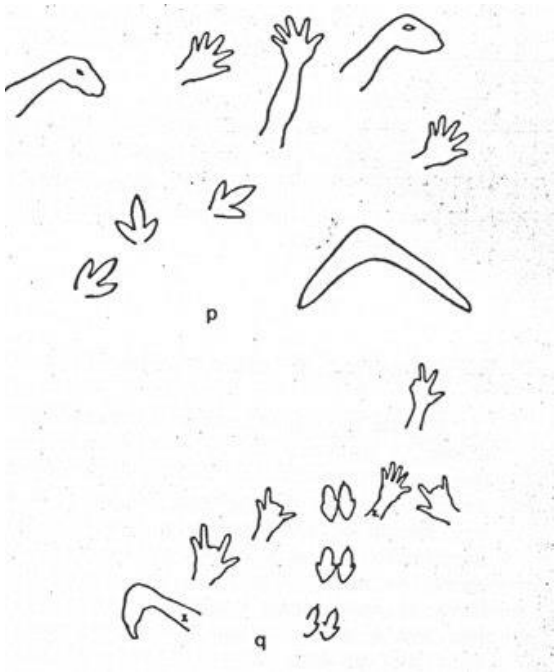
Figure 13. Walsh’s “composite panel” examples from central Queensland,